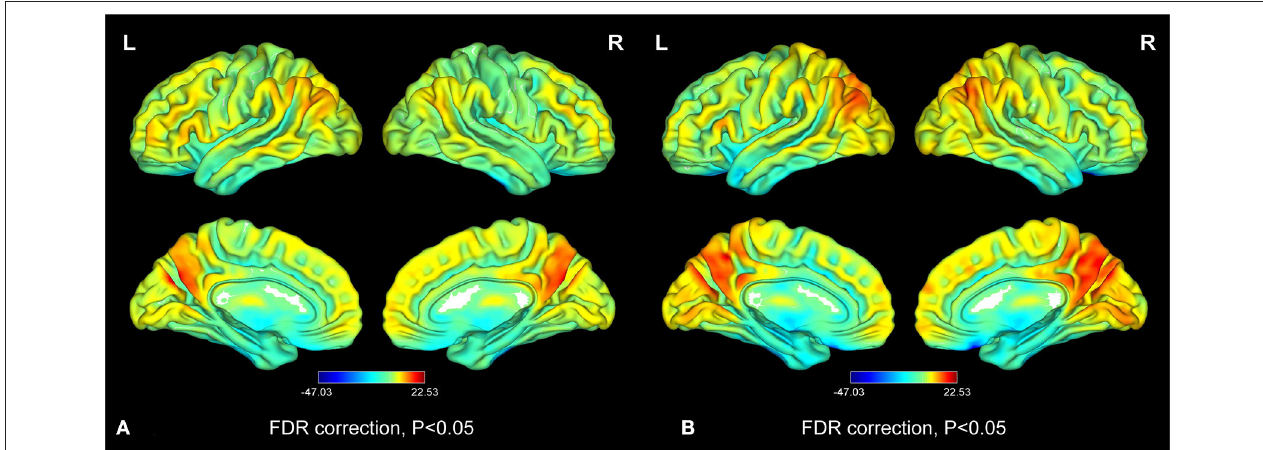
FIGURE 2 | Distribution patterns of the ReHo value at the group level in iridocyclitis patients and healthy volunteers. One-sample t -test result of ReHo maps within the iridocyclitis (A) and healthy volunteers (B) . The color bar represents the t -values (FDR correction, P < 0.05). Abbreviations: L, left; R, right; FDR, false discovery rate correction.